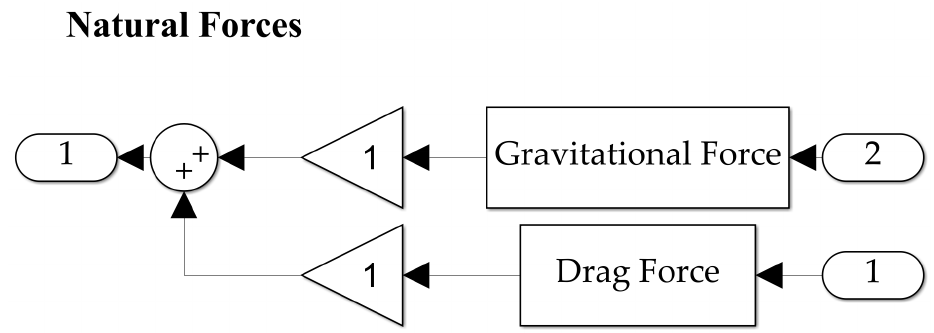
Figure A11. MatLab model with complete detailed display of the natural forces Simulink